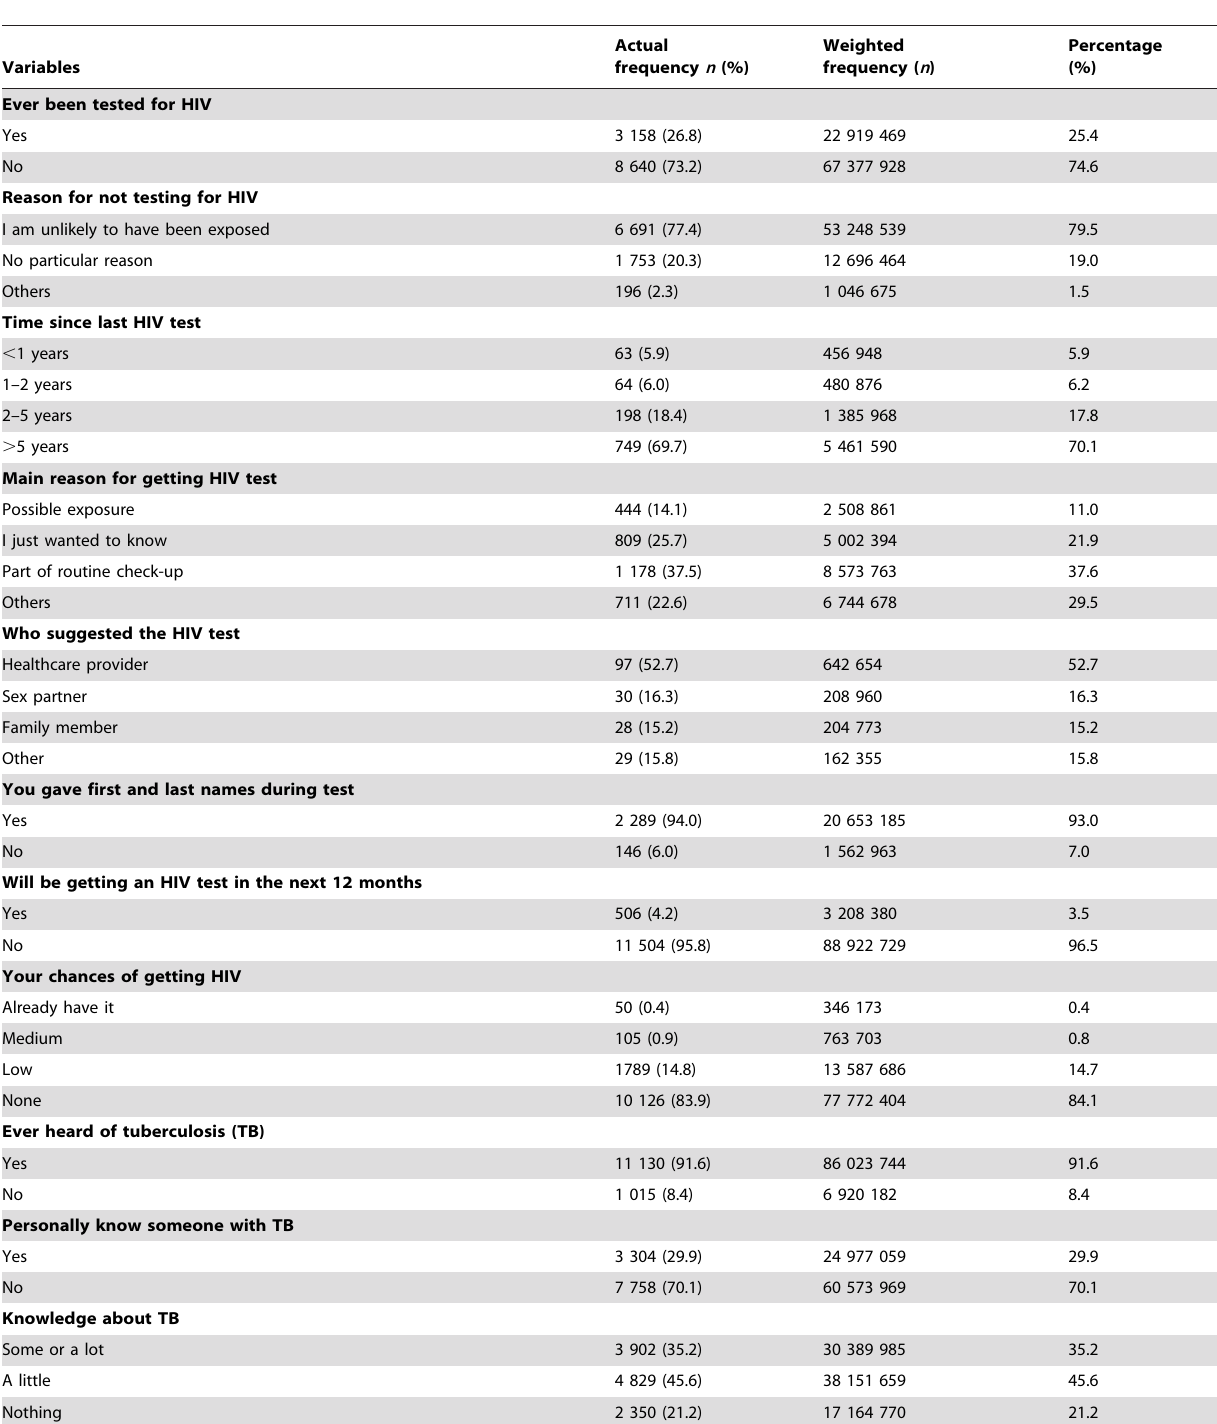
Table 2. Distribution of respondents by their attitude and practice of HIV testing and knowledge of HIV-related disease.